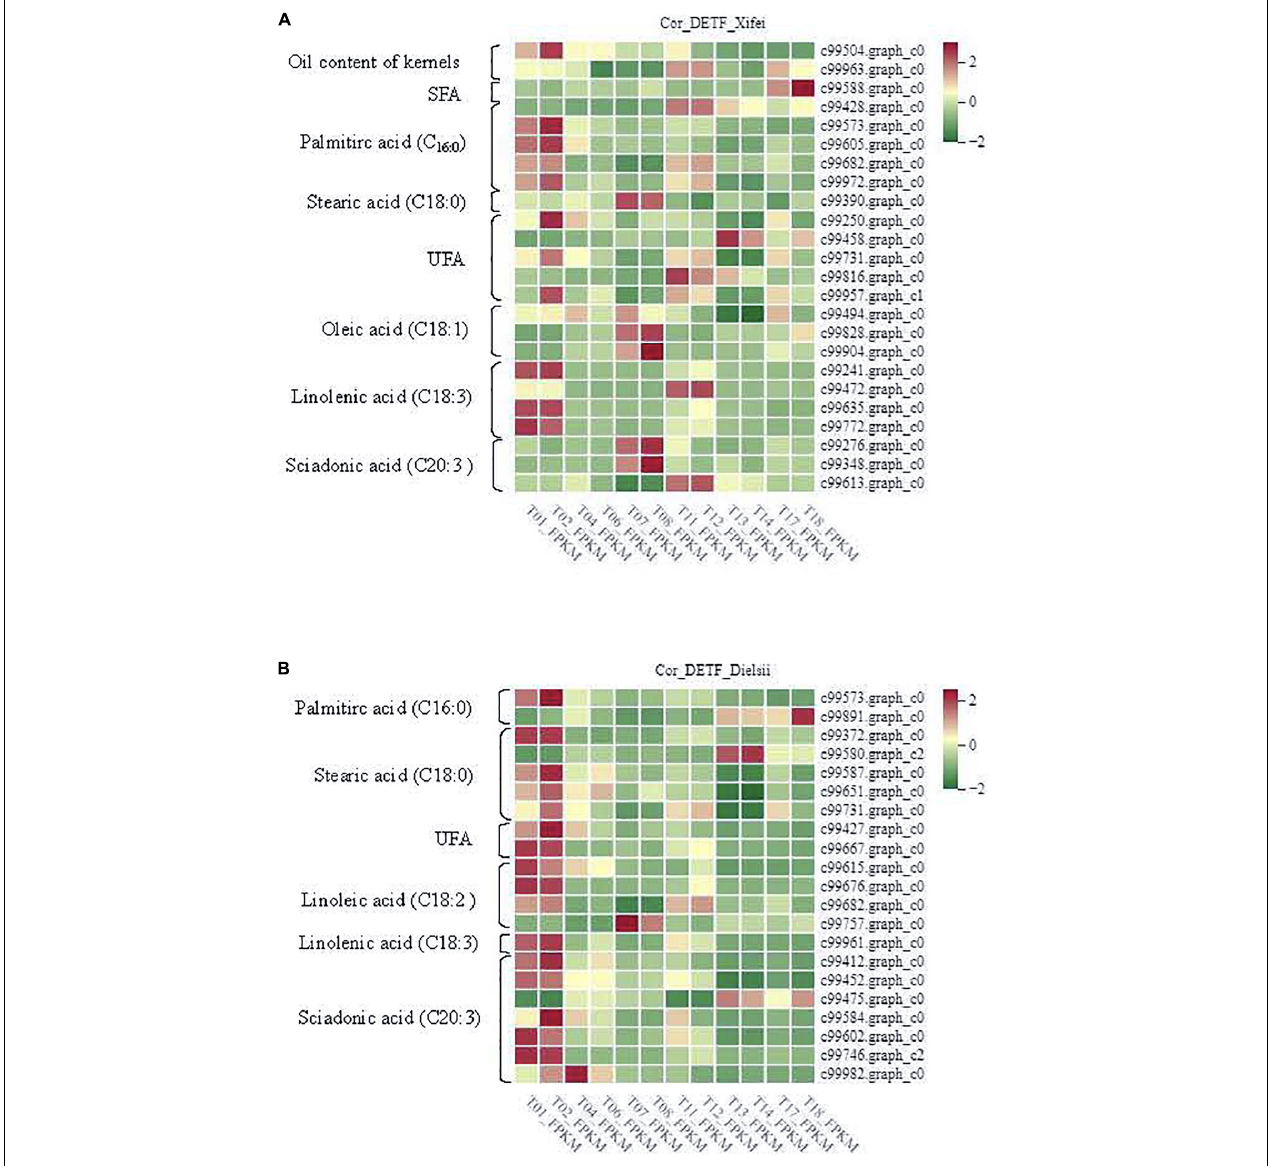
FIGURE 5 | Differentially expressed transcription factors (DETFs) were correlated to metabolites at different stages of kernel developments. (A) Samples termed as T01, T02, T04, T06, T07, and T08 represent the stage of the initiative, rapid and stationary oil accumulation in kernels of T. grandis ‘Xifei,’ respectively. (B) Samples termed as T011, T12, T13, T14, T17, and T18 represent the stage of the initiative, rapid and stationary oil accumulation in kernels of T. grandis ‘Dielsii,’ respectively. The correlated metabolite ( p < 0.01) was listed in the left